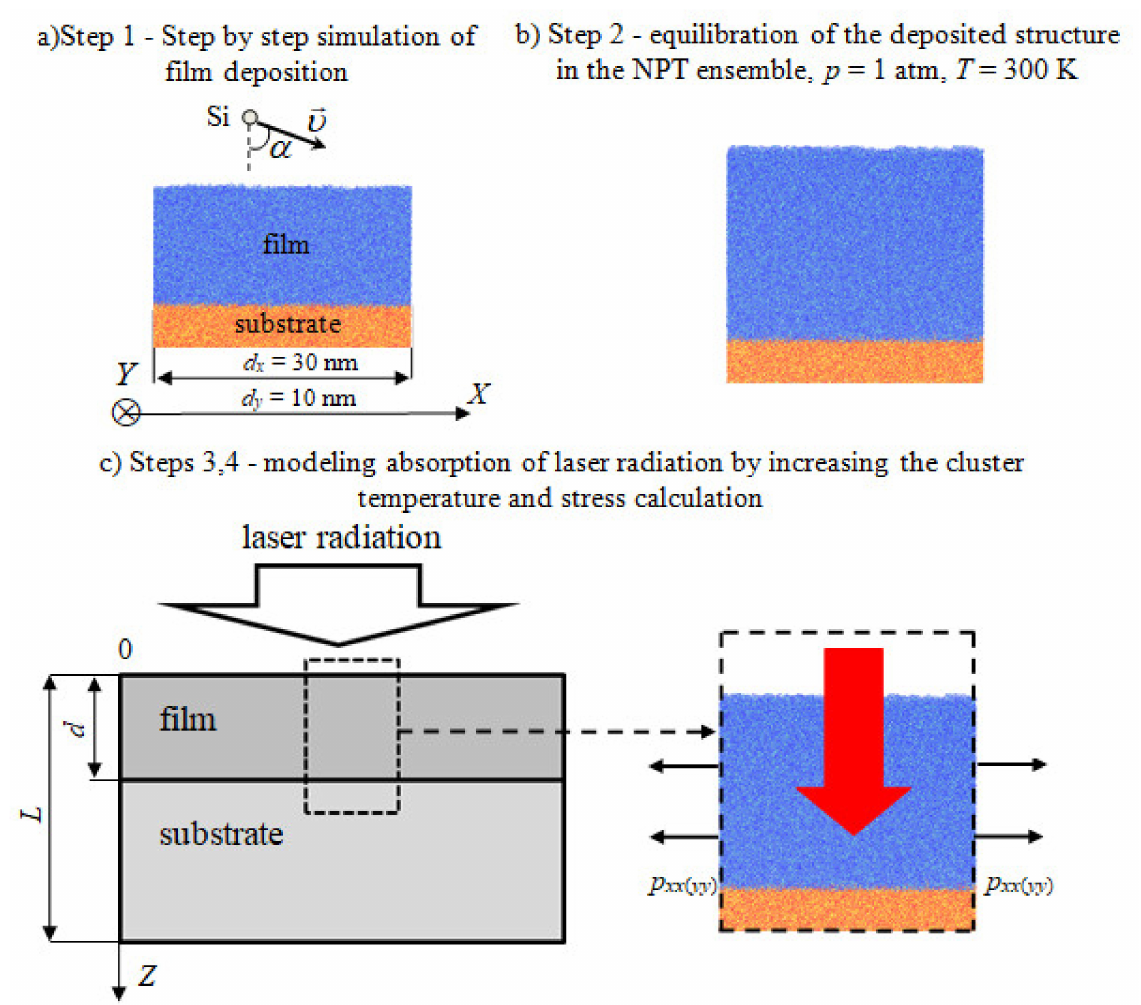
Figure 1. The scheme of the laser-induced stresses calculation, steps 1–4 are illustrated as follows: ( a ) Step 1—simulation of film deposition, ( b ) step 2—equilibration of the deposited structure in the NPT ensemble, ( c ) steps 3 and 4—modeling absorption of laser radiation by increasing the cluster temperature and stress